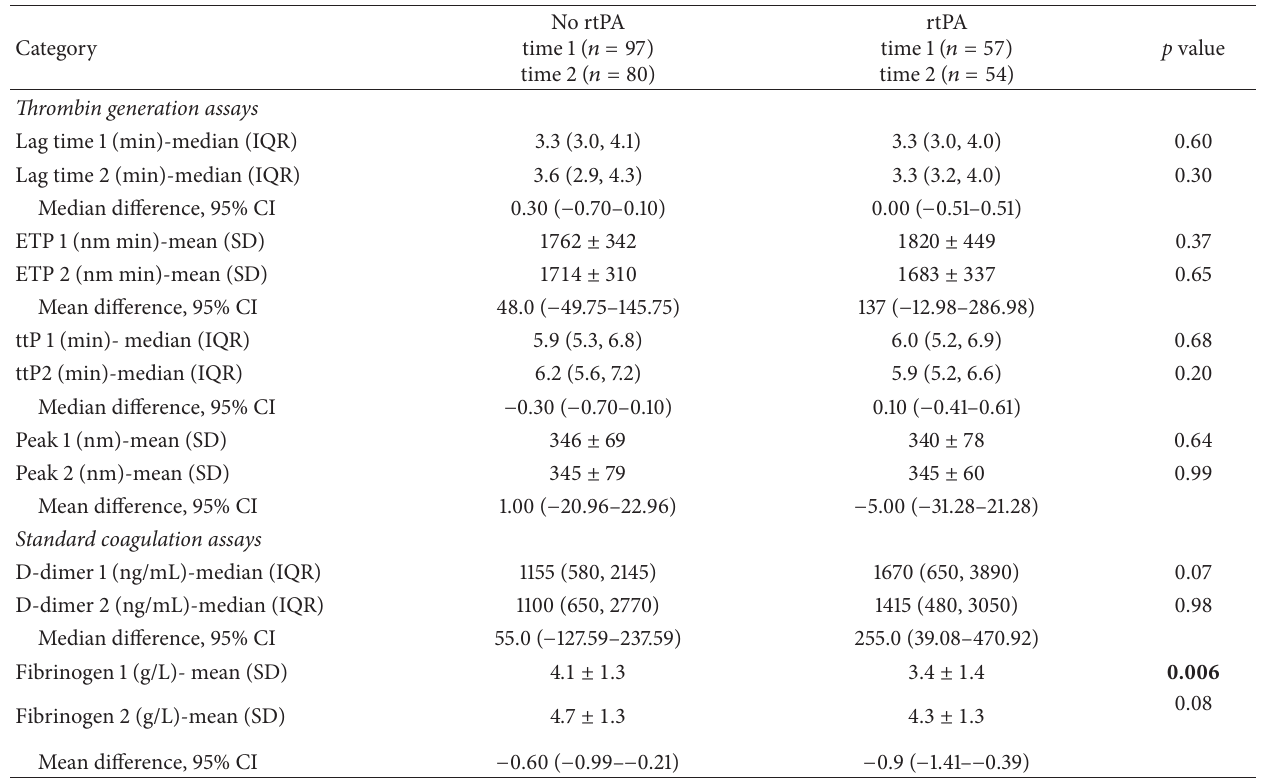
Table 5: Haemostatic activation after rtPA